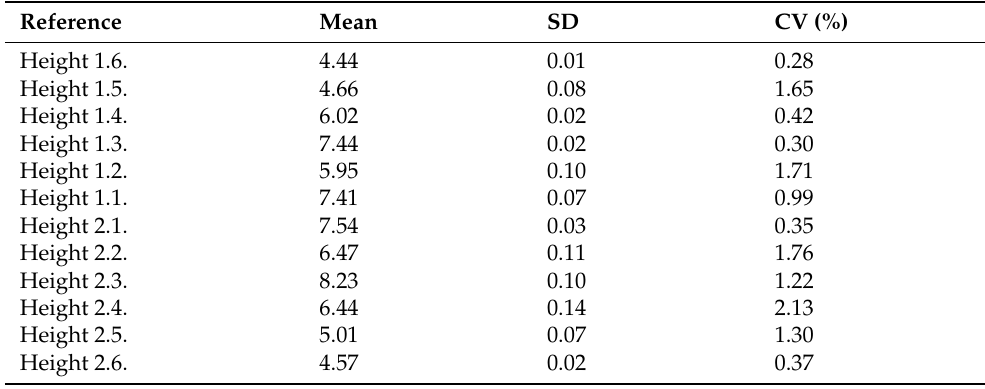
Table 1. Mean and SD in mm and Percentage Coefficient of Variation of measurements taken on 4 digital models created using